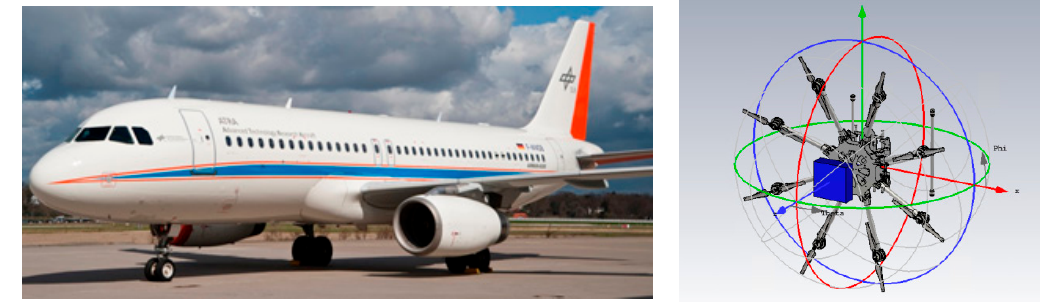
Figure 15. Left: DLR Advanced Technology Research Aircraft (“ATRA”): Airbus A320; right: DJI S1000 drone cad model.